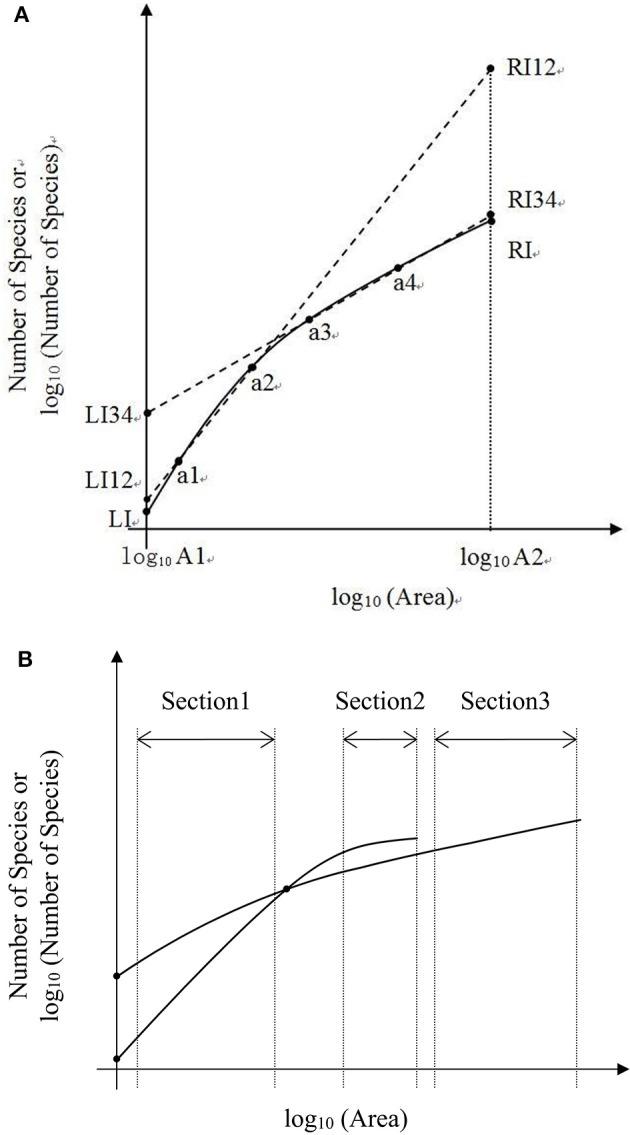
(A) Is the schematic diagram of one Species-Area Relationship for log10 (Area)−Number of Species or log10 (Number of Species). (B) Is the schematic diagram of two Species—Area Relationships for log10 Area−Number of Species or log10 (Number of Species).